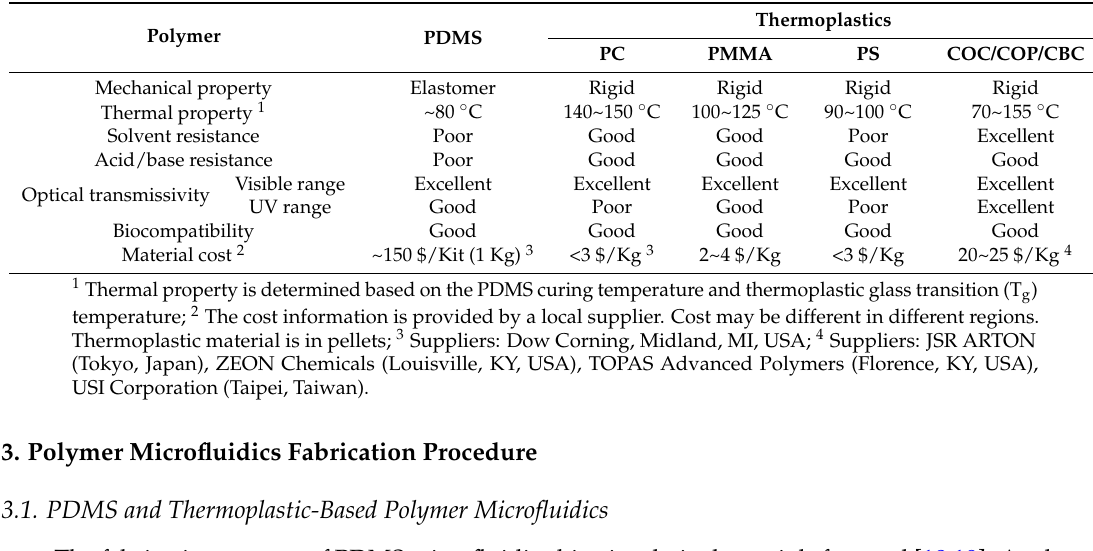
Figure 1. Polymer microfluidics fabrication process chart. The blue line indicates the PDMS-based microfluidics fabrication procedure, and the red line indicates the thermoplastic microfluidics fabrication procedure. Table 1. Summary of physical properties and suppliers for common polymer microfluidic materials.